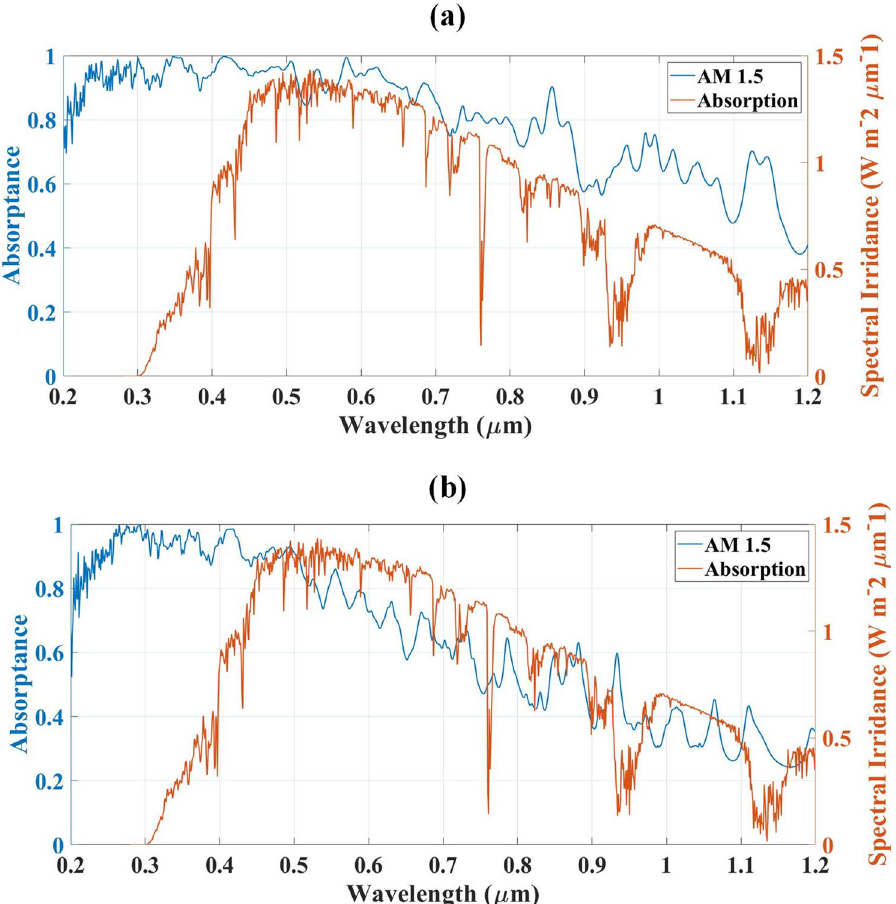
Figure 2. Absorption response comparison with AM1.5 specral irridance for ( a ) O-shape metasurface absorber design ( b ) L-shape metasurface absorber design. The O-shape metasurface absorber is having better absorption for all the regions.